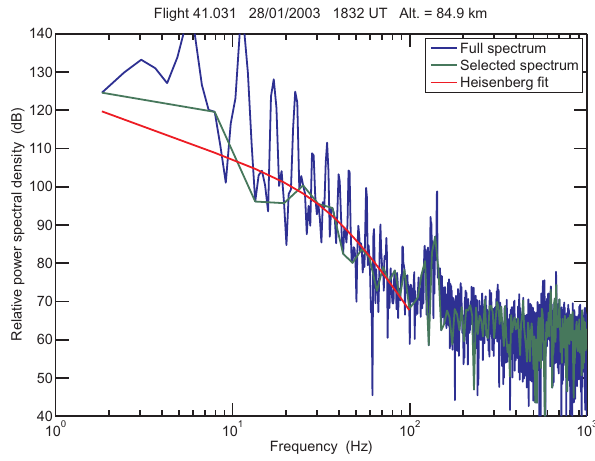
Fig. 10. Another example from Flight 41.031 of the use of fre- quency domain filtering to reduce the effects of payload roll modu- lation. At this altitude of 84.9km, the quality of the Heisenberg fit is not as good.